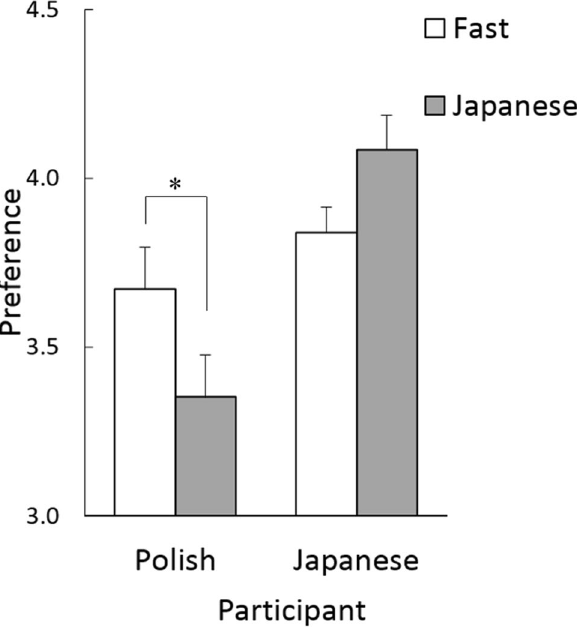
Figure 2. Mean (with SE ) preference ratings for fast food and Japanese food by Polish and Japanese participants. * p < 0.05.